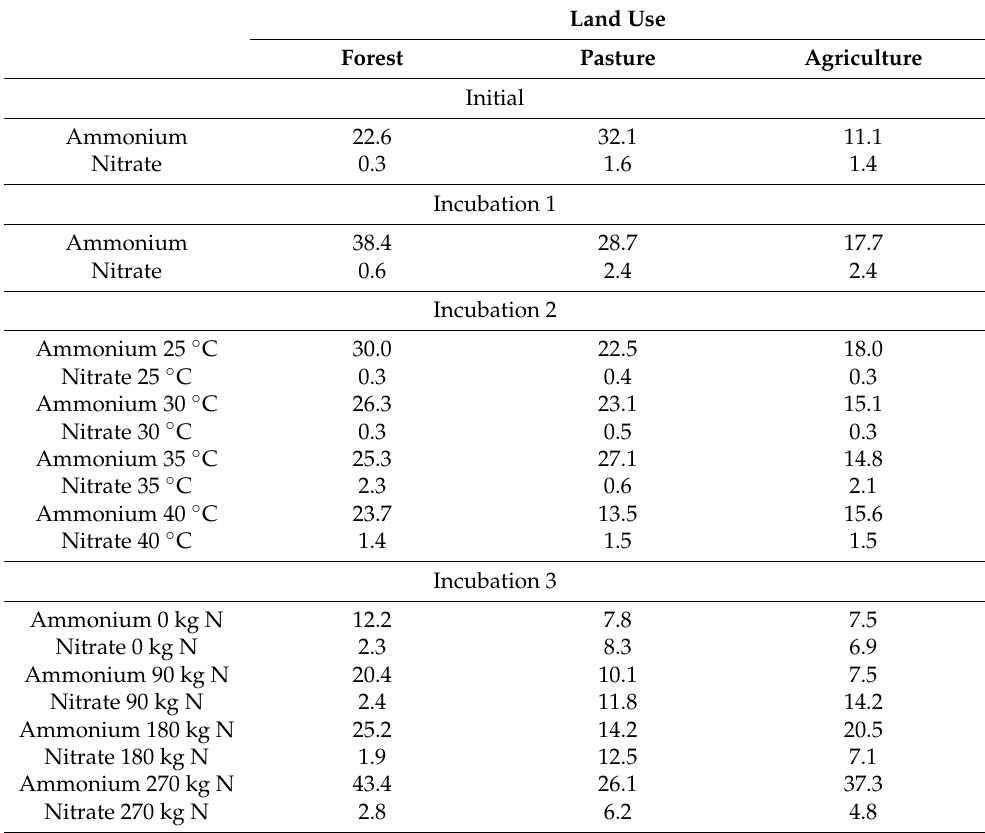
Table 4. Concentrations of ammonium (mg N NH 4 kg − 1 dry soil) and nitrate (mg N NO 3 kg − 1 dry soil) in soils of different land-use systems under incubation temperature and nitrogen input. Land Use Forest Pasture